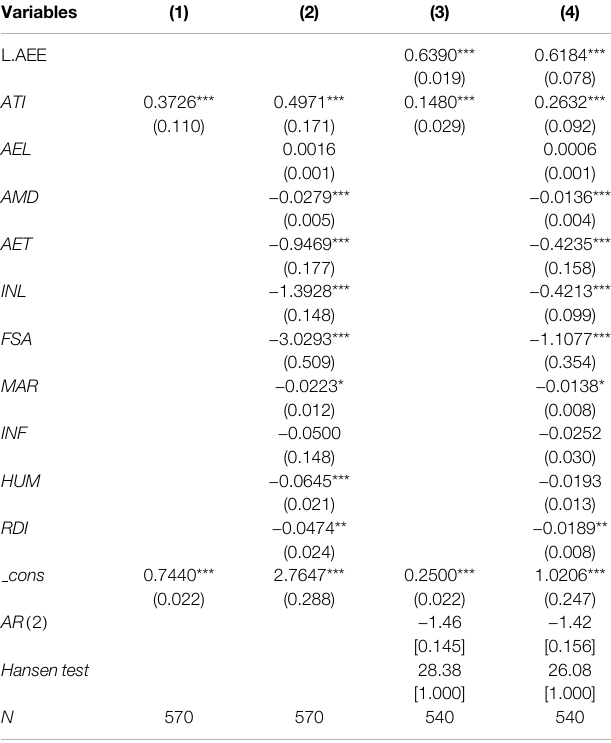
TABLE 3 | Baseline regression